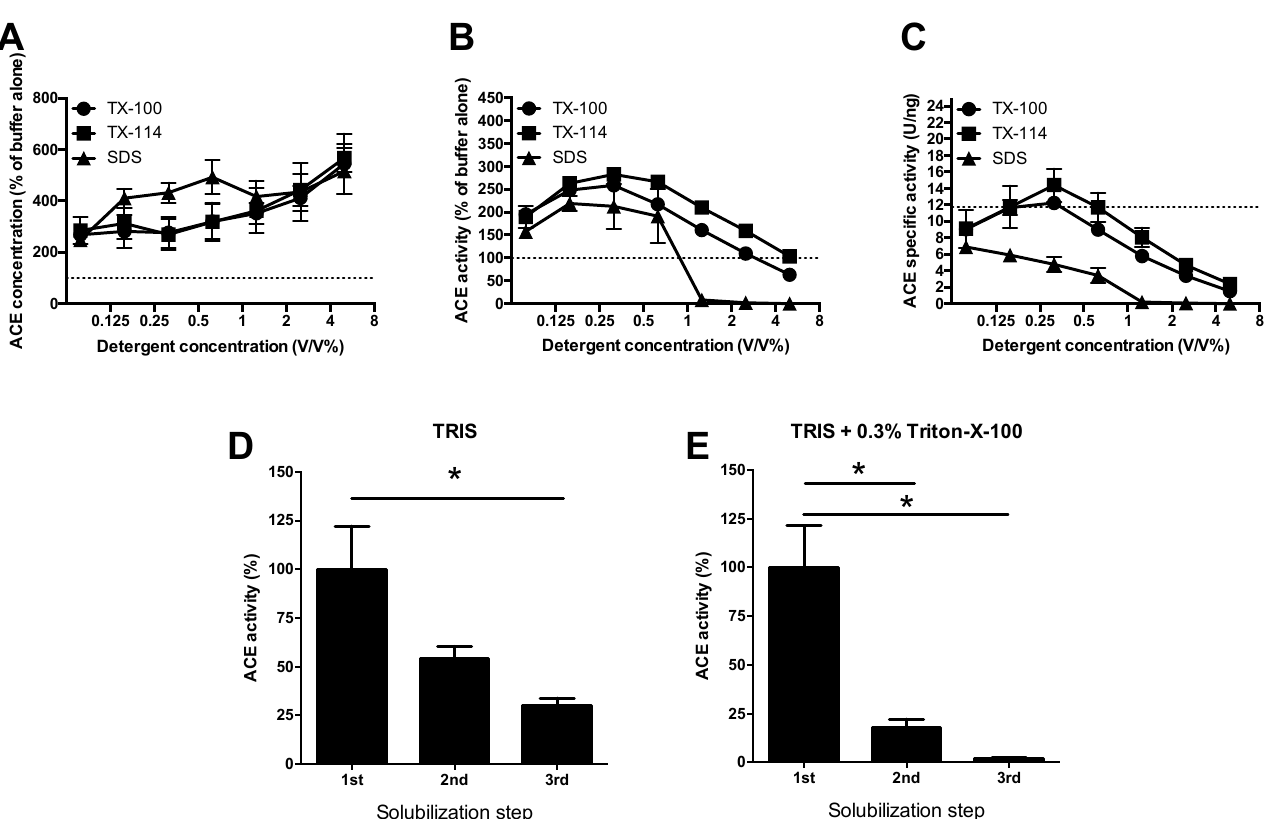
Figure 1. ACE extraction method—A role for detergents. Human lung tissue samples were homogenized in SDS, Triton- X-100 and Triton-X-114 containing buffers. Final concentrations in activity measurements are shown on the x-axes (note, homogenates were two-fold diluted in the activity measurement mixture). The homogenates were centrifuged and the supernatants were collected, diluted to 1 mg/mL (with the same buffer, containing the indicated detergents). ACE concentration was measured by ELISA ( A ), while activity was measured by a kinetic assay ( B ). The ratio of the activity and concentration values yielded the specific activity, which is shown in ( C ). In some cases, the homogenization procedure was repeated using the ACE depleted pellets after homogenization. The number of these repeated extraction cycles is indicated in panels ( D , E ). In these cases, the ACE activity was expressed as the percentage of the first supernatants (( D ): buffer without detergent, ( E ): Buffer with 0.3% Triton-X-100). Symbols ( A – C ) and bars ( D , E ) represent the mean, error bars show the S.E.M. of n = 5–9. Significant differences ( p < 0.05) are labelled by the